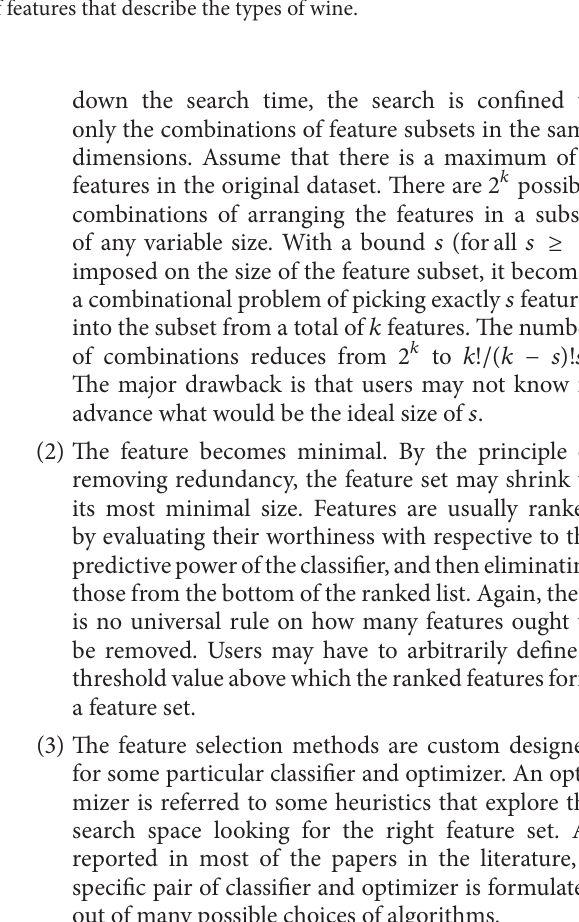
Figure 1: Visualization of multidimensions of features that describe the types of